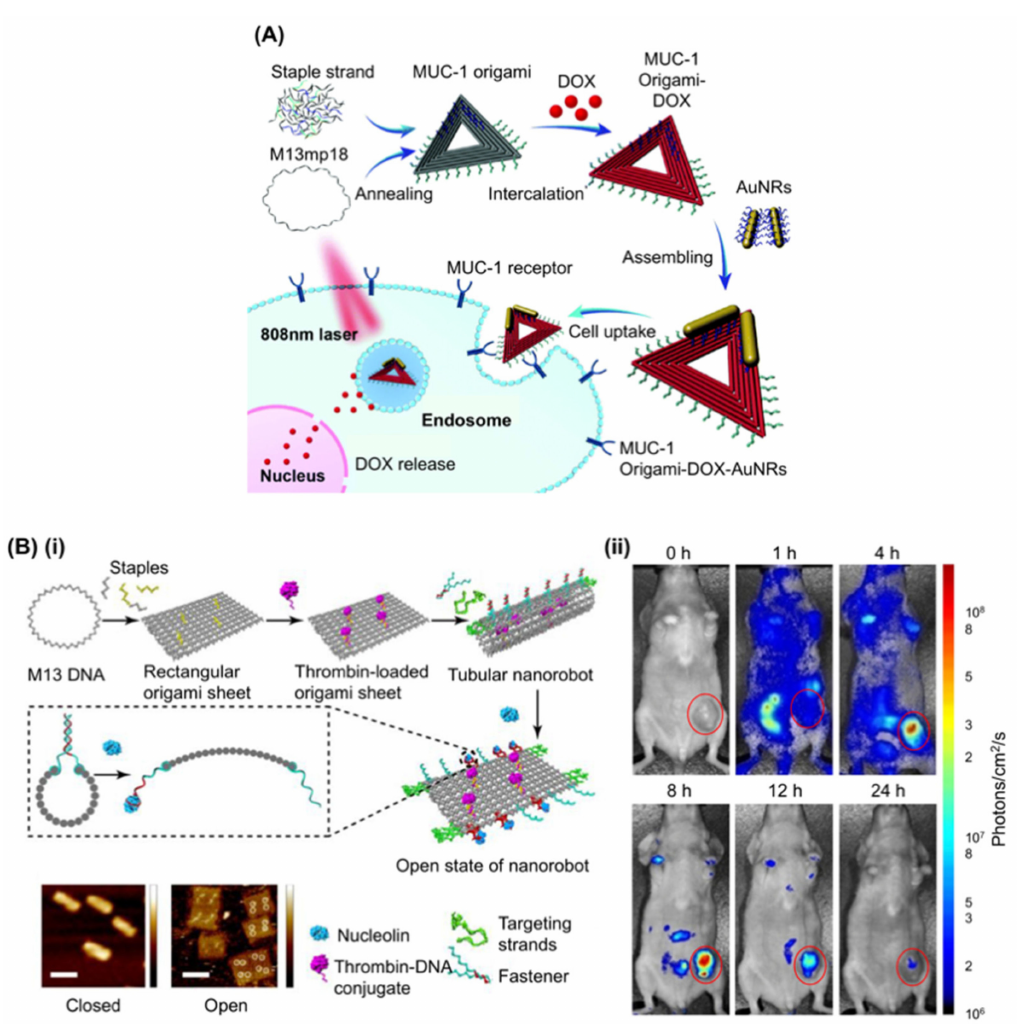
Figure 4. Examples of aptamer use in cell targeting of DNA origami. ( A ) Schematic showing that triangle DNA origami functionalized with the Mucin 1 protein (MUC-1) aptamer can load doxorubicin and carry AuNRs to inhibit the growth of resistant breast cancer cells. The triangular shaped DNA origami structure is hybridized with staple strands (grey), MUC-1 aptamer strands (green), and capture strands (blue). The multifunctional DNA nanostructures (MUC-1 aptamer–DNA origami–DOX–AuNRs complex, MODA) were administered to the MCF-7/ADR cells and the photothermal effects were investigated. Adapted with permission from Song et al., Nanoscale, 2017 [87]. ( B ) ( i ) ( top ) Schematic showing the construction of a thrombin-loaded nanorobot by DNA origami and its change of shape into a rectangular DNA sheet in response to nucleolin binding. ( bottom ) AFM images of the DNA nanorobots in closed ( left ) and opened states ( right ). The four bright spots displayed on the surface of the origami sheet represent the thrombin molecules. ( ii ) In vivo experiment to show the activity of aptamer-based DNA nanorobots. Optical imaging of an MDA-MB-231 mouse bearing a human breast tumor before and after intravenous injection of Cy5.5-labeled nanorobot. A high-intensity fluorescent signal was detected only in the tumor region of mice 8 h after injection. 0 h indicates before injection. Adapted with permission from Li et al., Nat. Biotechnol., 2018 [91]. AuNR: Gold nanorod; DOX: